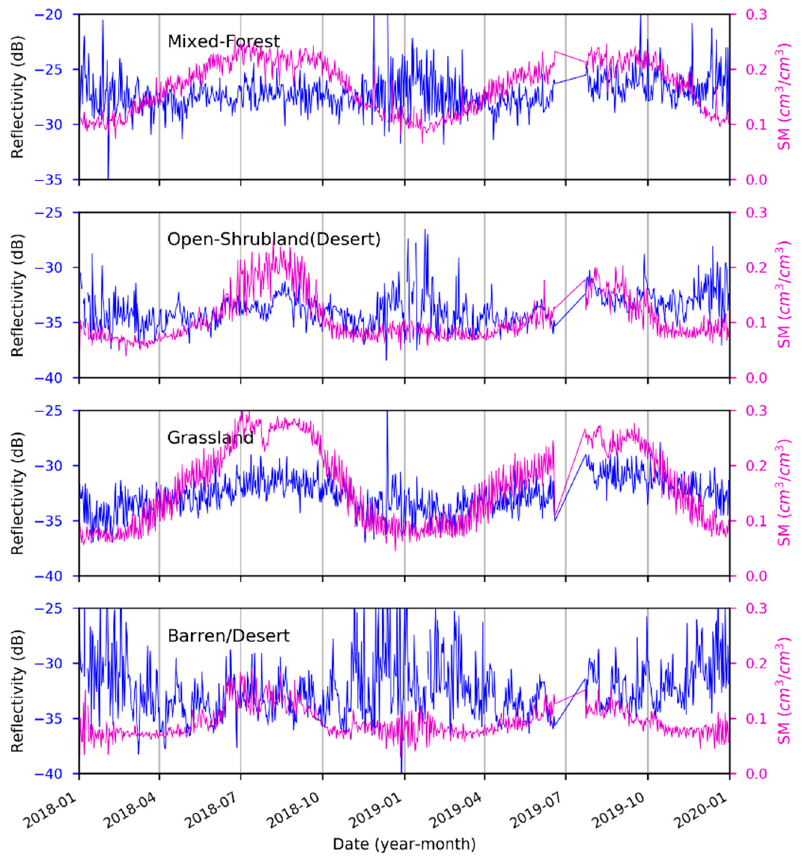
Figure 6. The time series of average surface reflectivity versus SMAP average soil moisture under different land cover types on Tibetan Plateau.